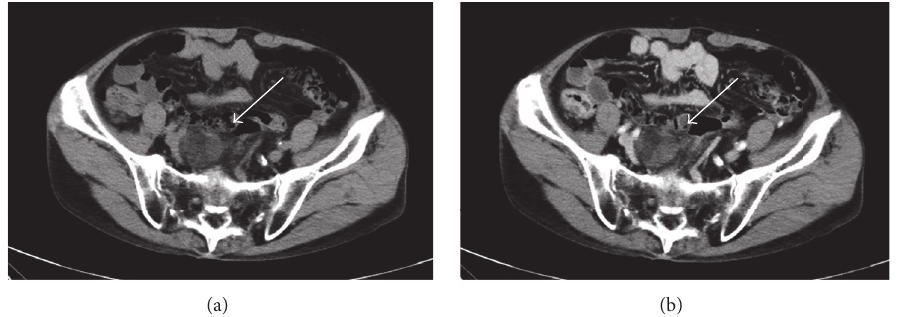
Figure 1: Enhanced CT scan showed a heterogenous round mass in the presacral space (diameter: 43mm) that contained low-density areas ((a) plane, (b) arterial